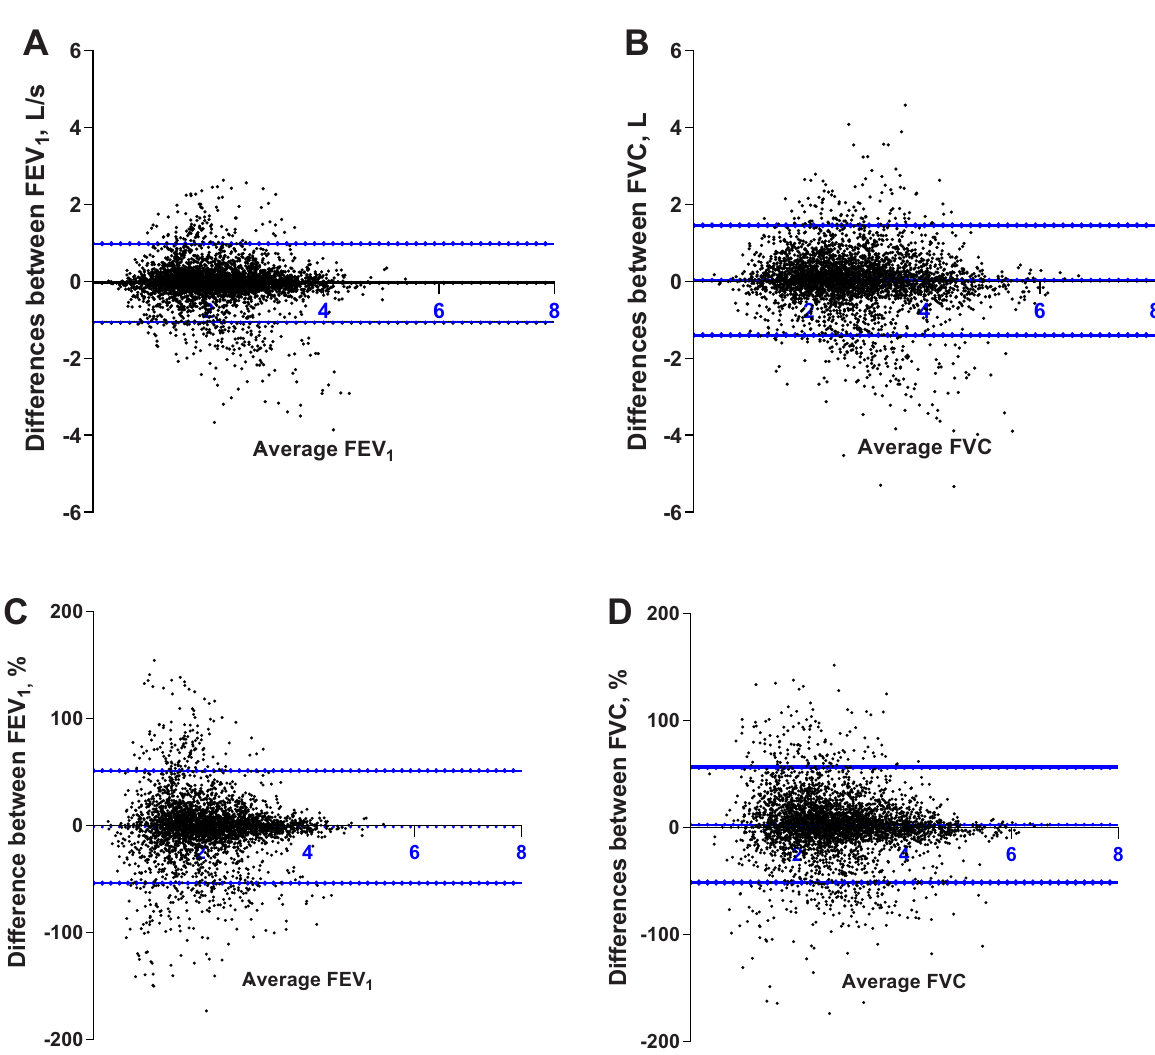
Fig 2. Bland-Altman plots for paired FEV1 and FVC measured by the microGP abd EasyOne spirometers. Differences between paired FEV1 and FVC were calculated as the absolute mean difference (EasyOne minus microGP) in Panels And B; or the relative mean difference (EasyOne minus microGP)/average � 100) in Panels C and D; plotted against the average ((EasyOne+microGP) 2) on the x-axis. The 95% Limits of Agreement (LoA) are provided (blur lines). The 95% CI for the mean differences and LoA are also provide (broken Line).